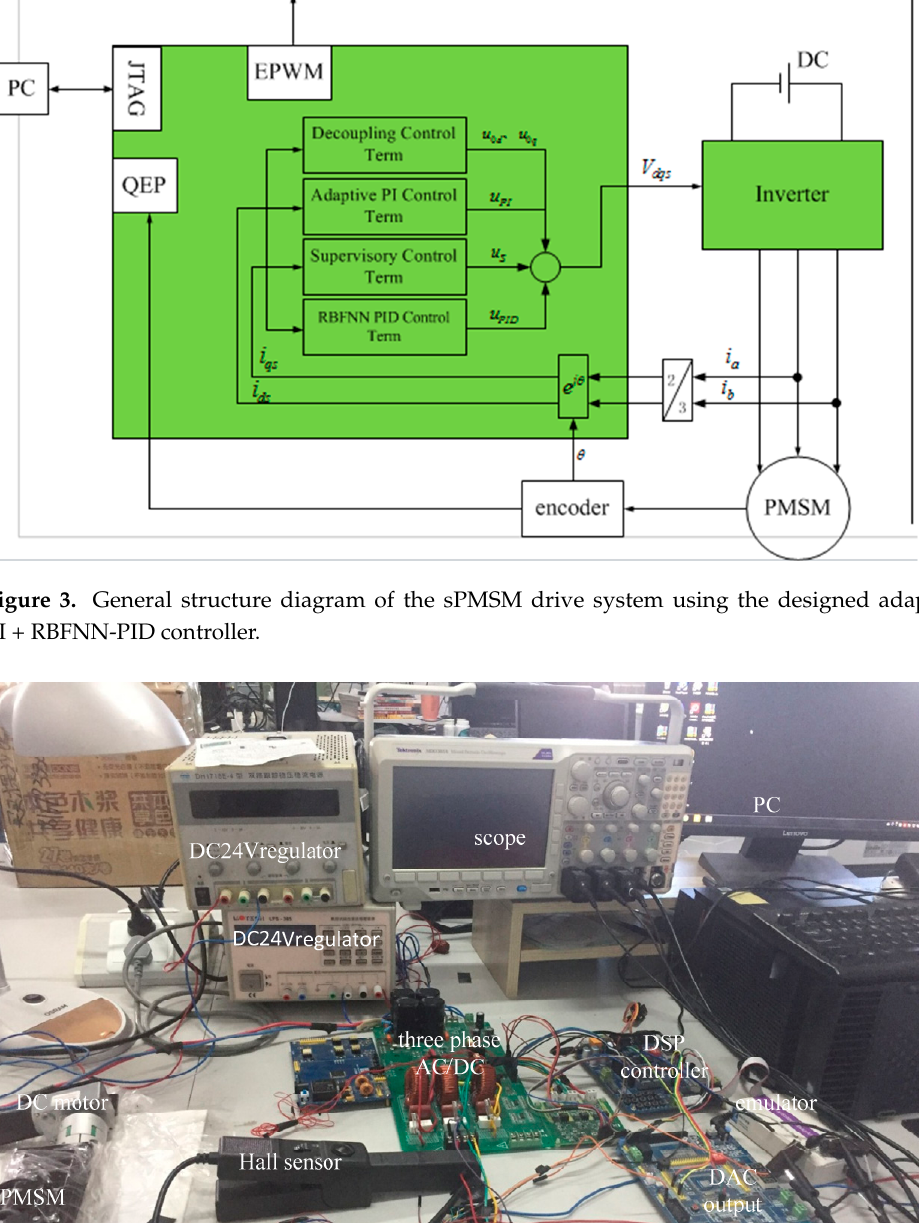
Figure 2. The program of the designed adaptive PI + RBFNN-PID control algorithm [34,35].